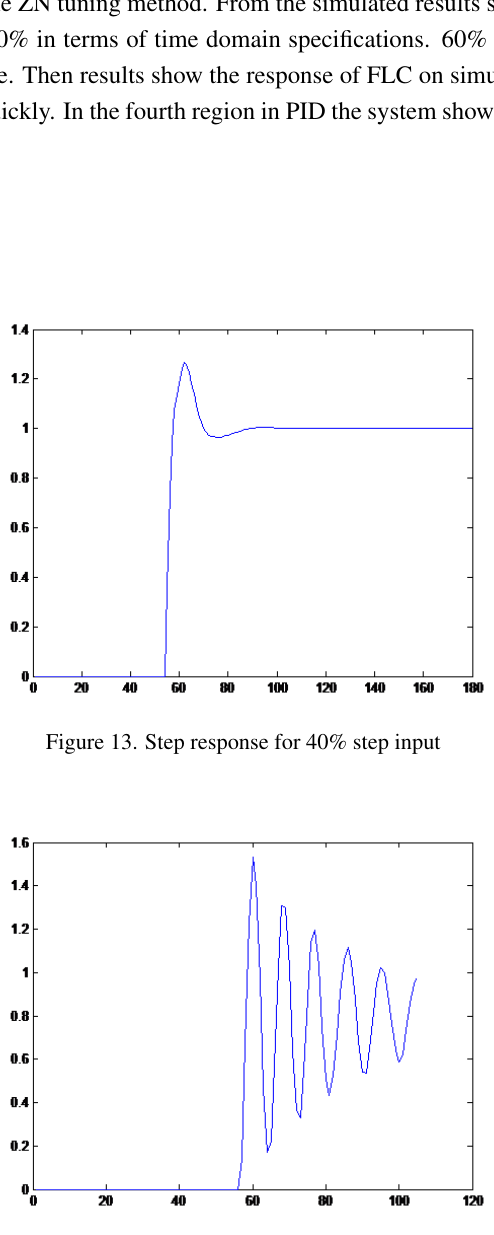
Figure 14. Step response for 60% step